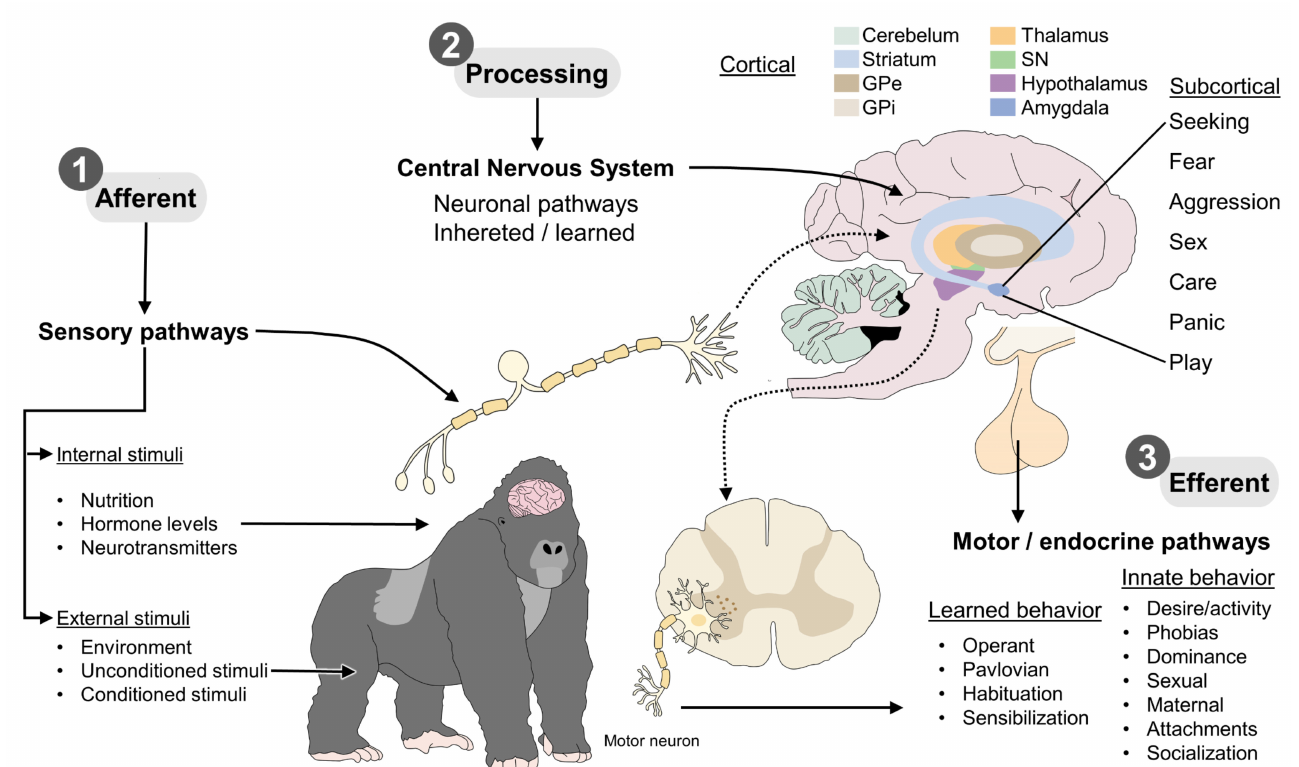
Figure 1. The big picture of how the neurobiology of behavior is relevant for animal welfare. All animals share general mechanisms of afference, processing and efference. The nervous system receives inputs from internal or external stimuli. Inputs are processed in various subcortical neurobiological systems to generate innate physiological and emotional responses that result in overt behavioral patterns. It can also be integrated into neurocircuits that employ learning to compare information stored in the form of memories to facilitate the expression of behavioral patterns. GPe: globus pallidus externus; GPi: globus pallidus internus; SN: sustantia